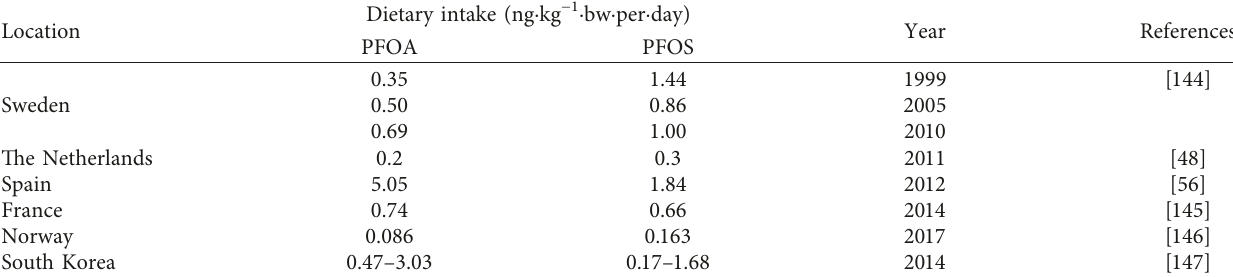
Table 2: Summary of recent estimates of dietary intake of PFOA and PFOS in various countries.